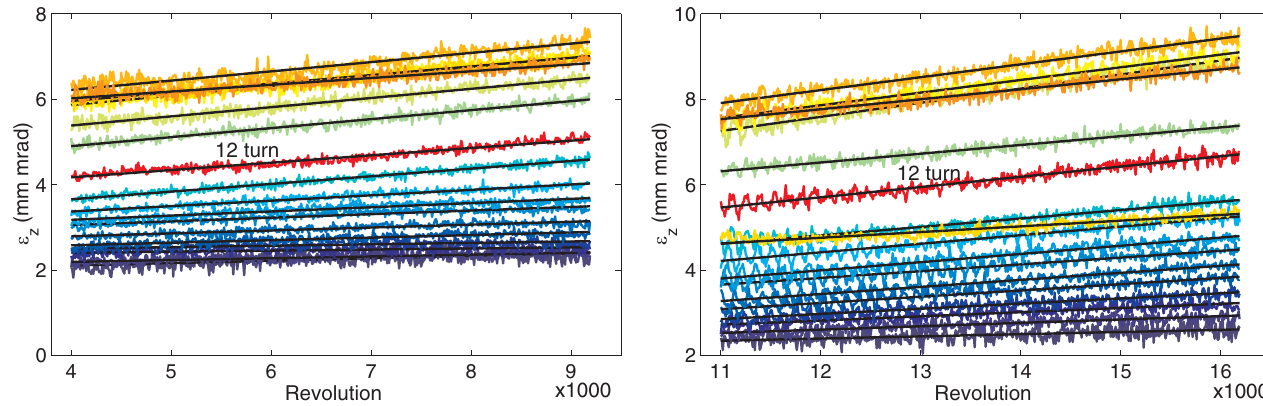
FIG. 8. (Color) Left: The normalized vertical rms emittance from 4001 revolution to 9200 revolution for all data sets with 2-turn injection to 18-turn injection. Right: The normalized vertical rms emittance from 11001 revolution to 16200 revolution for all data sets with 2-turn injection to 18-turn injection. Note 16-turn data set lost a big fraction of beam at transition and thus has smaller emittance here.